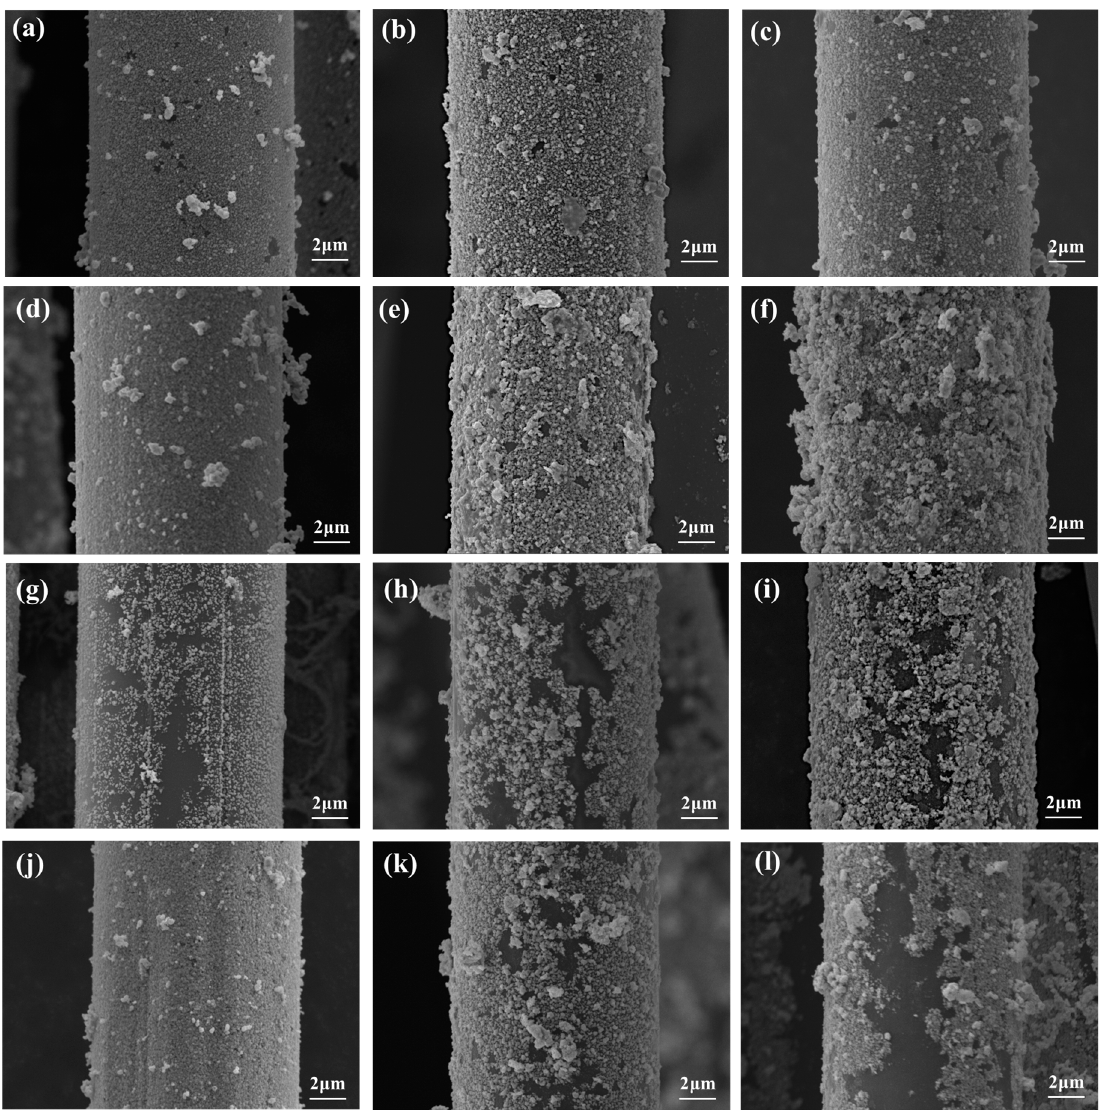
Figure 11. SEM images of plasma-treated PPTA-PDA/Ag fibers prepared at AgNO 3 concentrations of 5 ( a ), 10 ( b ), 15 ( c ), 20 ( d ), 25 ( e ) and 30 ( f ) g/L and plasma-treated PPTA-PDA/Ag fibers after 10 washing cycles correspond to ( g – l ) (5–30 g/L).